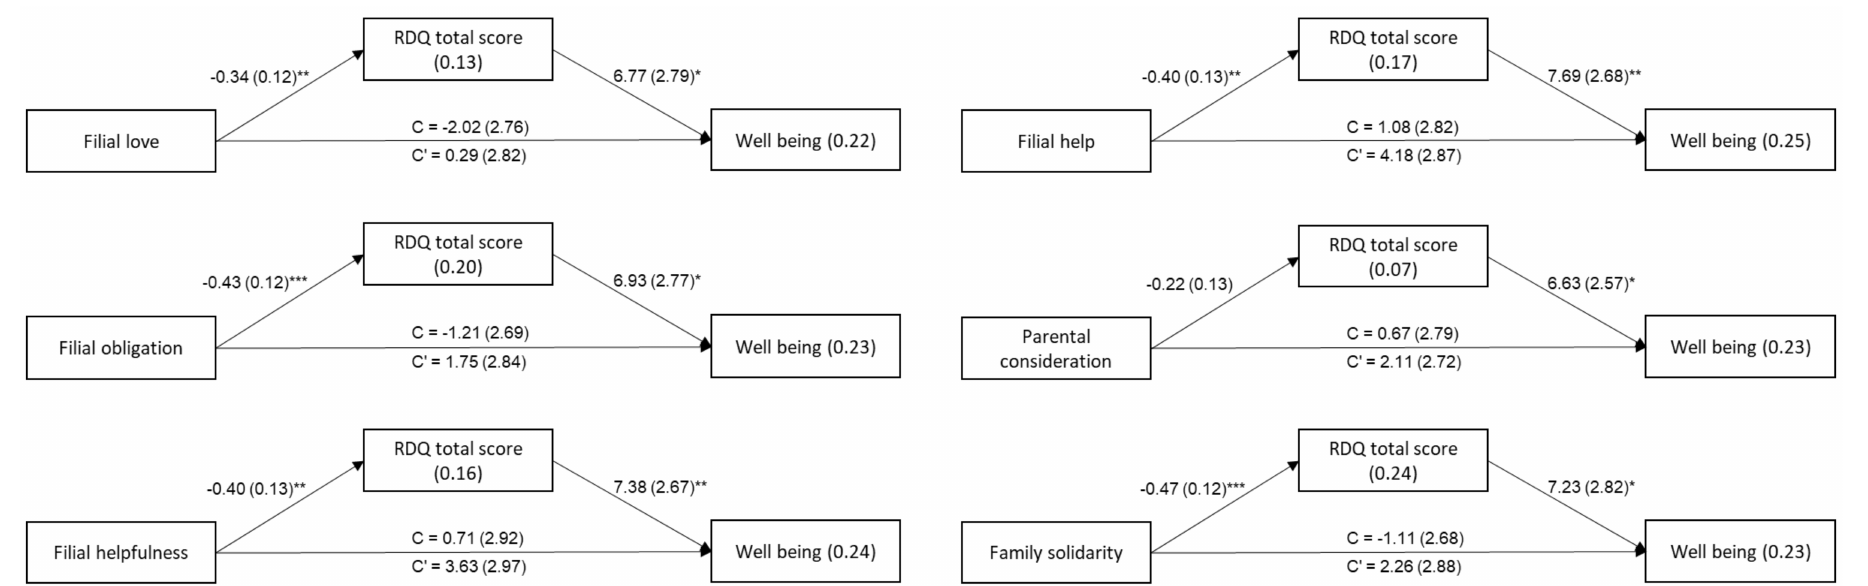
Figure 1. The Mediating Role of RDQ in the Relationship between Filial Maturity and Well-Being. Note. Values on the arrows are B (SE); values within the rectangles are R 2 , C = total effect, C’ = direct effect. * p < 0.05, ** p < 0.01, *** p <